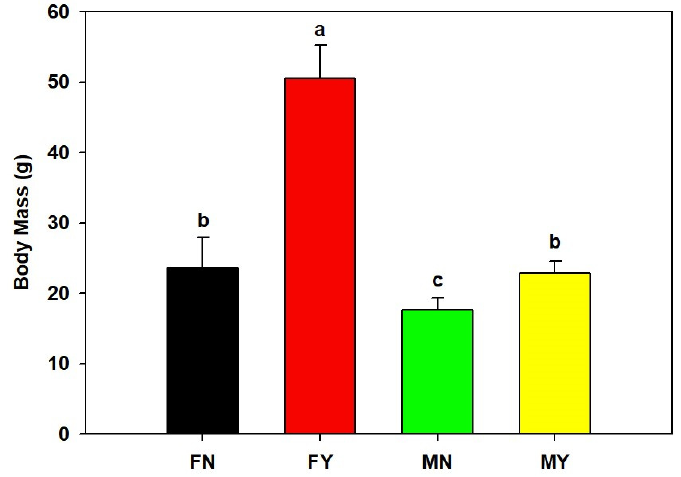
Figure 2. Body masses of dwarf-form populations of Sthenoteuthis oualaniensis. Significant differences are indicated by different letters ( p < 0.05).